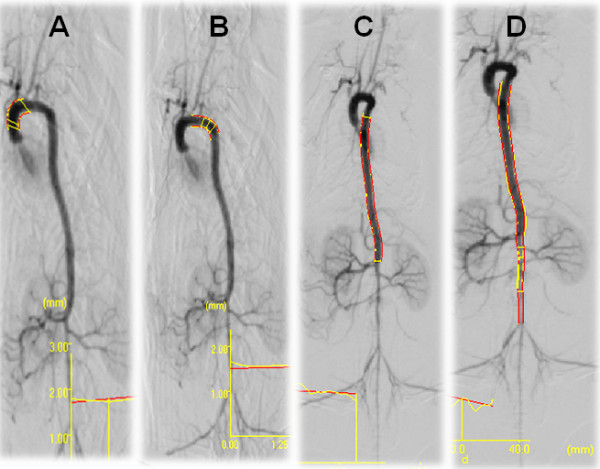
Typical angiography analysis of the internal diameter (parallel red lines) of the aorta divided into four segments: A) ascendant aorta - left common carotid; B) left common carotid - descendant thoracic portion of aorta; C) descendant thoracic portion of aorta - right renal artery; D) descendant thoracic portion of aorta - bifurcation of the common iliac artery. For a better visualization, A and B images were performed at an angle of 45° whereas C and D were at 0°.